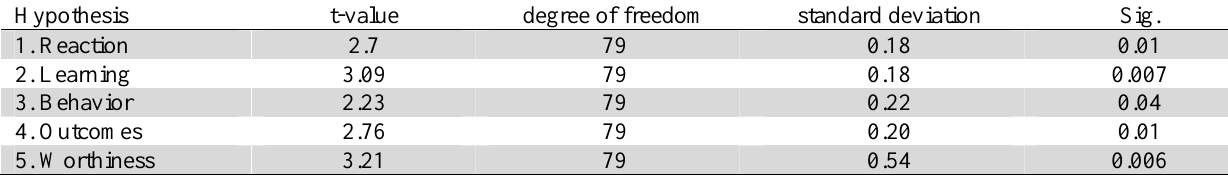
The summary of testing the hypotheses of the survey in terms of mayors’ viewpoint Hypothesis t-value degree of freedom standard deviation